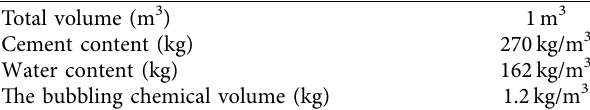
Table 1: The mixture design of the foamed